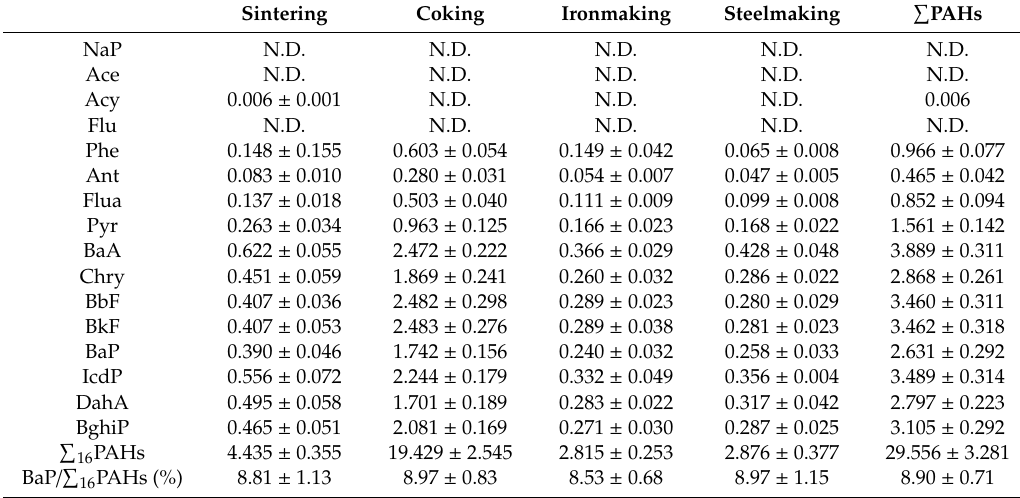
Sintering Coking Ironmaking